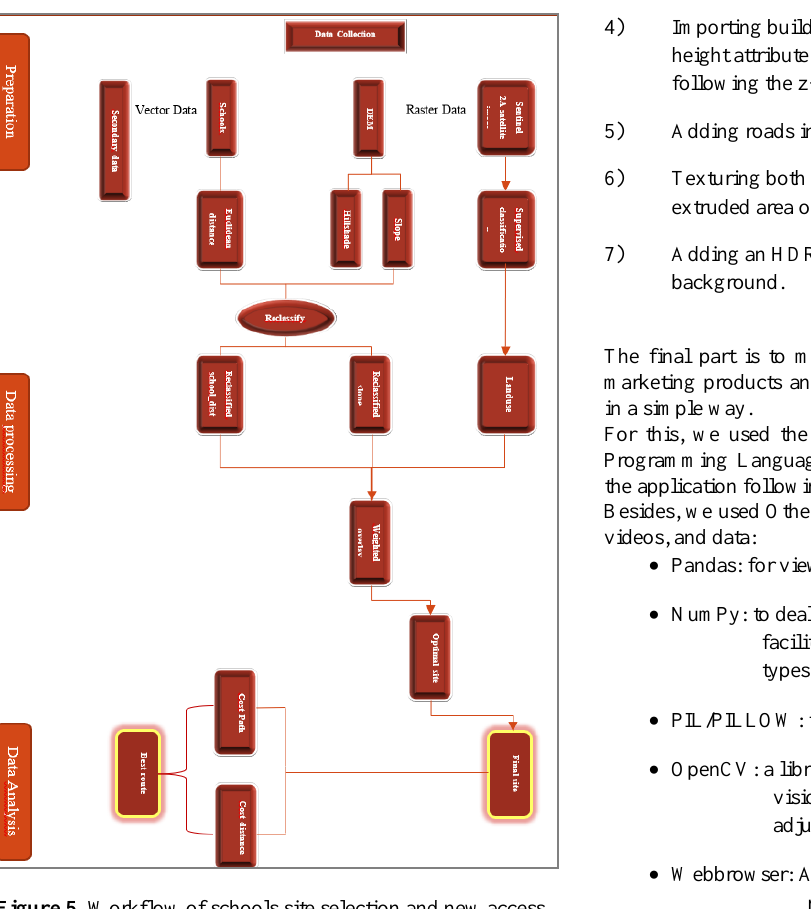
Figure 5 . Workflow of schools site selection and new access road finding.